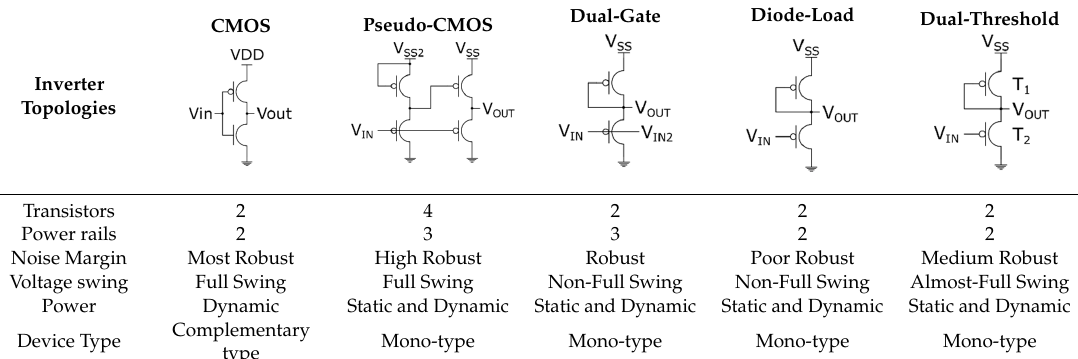
Table 1. Comparison of different topologies of OTFT design styles for basic inverters with key parameters. CMOS Inverter Topologies